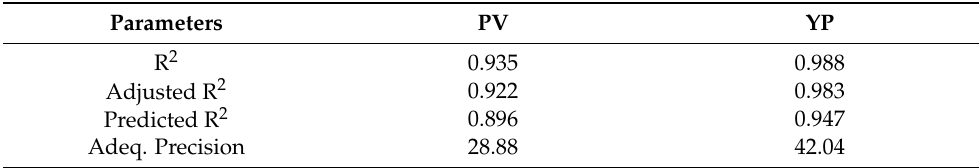
Table 6. R 2 and adjusted R 2 values of the models.